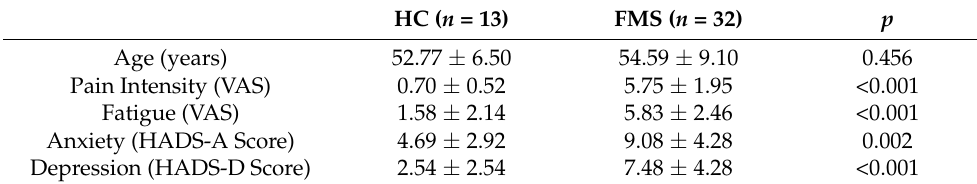
Table 1. Clinical characteristics of HCs and FMS patients. Data (Mean ± SD).